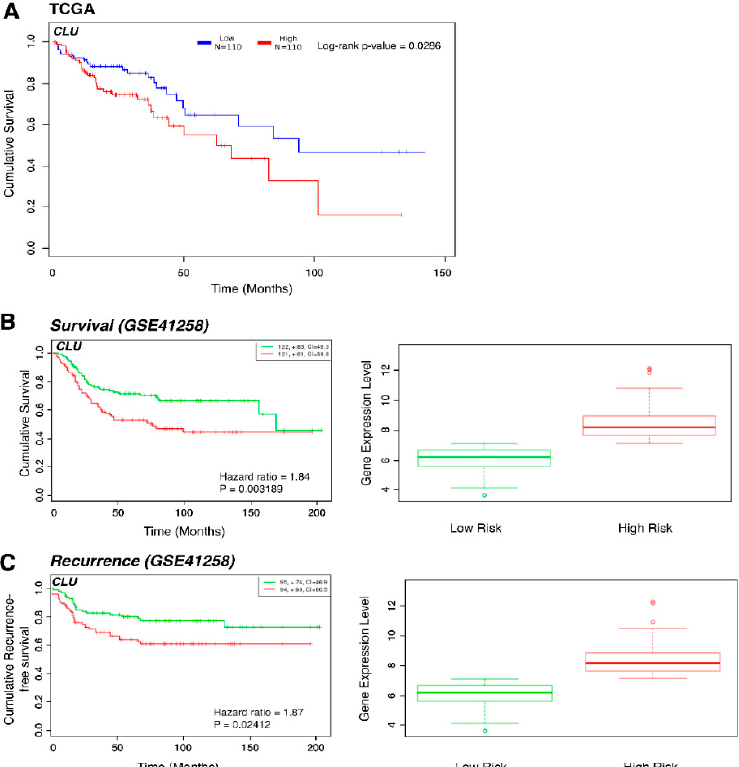
Figure 3. CLU expression in colon adenocarcinoma patients is associated with decreased overall survival. ( A ): Kaplan–Meier survival plot comparing The Cancer Genome Atlas (TCGA) colon adenocarcinoma patients with high ( N = 110) and low ( N = 110) expression of CLU using the OncoLnc tool. The associated log-rank p -value is 0.0286. ( B ): Kaplan–Meier survival plot for high- (red, N = 121) and low- (green, N = 122) risk groups in GSE41258 database by SurvExpress tool shows cumulative survival against time (months) and the box plot shows the corresponding CLU expression across groups. The number of individuals, the number of censored, and the CI of each risk group are shown in the top-right insets. Censoring samples are shown as “+” marks. ( C ): Kaplan–Meier survival plot for high- (red, N = 95) and low- (green, N = 94) risk groups in GSE41258 database by SurvExpress tool shows cumulative recurrence-free survival against time (months) and the box plot shows the corresponding CLU expression across groups. The number of individuals, the number of censored, and the CI of each risk group are shown in the top-right insets. Censoring samples are shown as “+” marks.